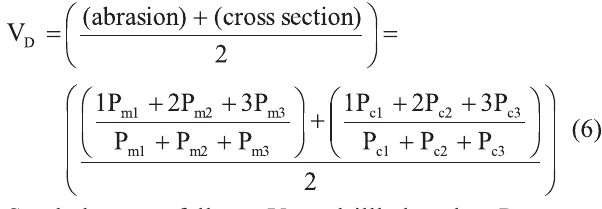
Fig. 3. SEM microphotographs of poorly preserved Echinocyamus pusillus Müller, 1776 (sample GPIT/EC/00740) from Giglio Island, Recent. A . Highly abraded specimen gg-3b-2.10, in aboral view, showing fragmentation and moderate external and internal encrustation by serpulids (arrows). B . Specimen gg-3b-2.17, in aboral view, showing showing fragmentation and high test surface abrasion (arrow) on the right side (B 1 ). Details of B 1 , showing moderate abrasion of the tubercles and ambulacral pores (B 2 ); high surface abrasion revealing the underlying stereom of the test (B 3 ). C . Specimen gg-3t-2.26, mod- erately abraded tubercle with perforated mamelon and boss still present (C 1 ); highly abraded tubercle with boss present, but the mamelon entirely gone (C 2 ).